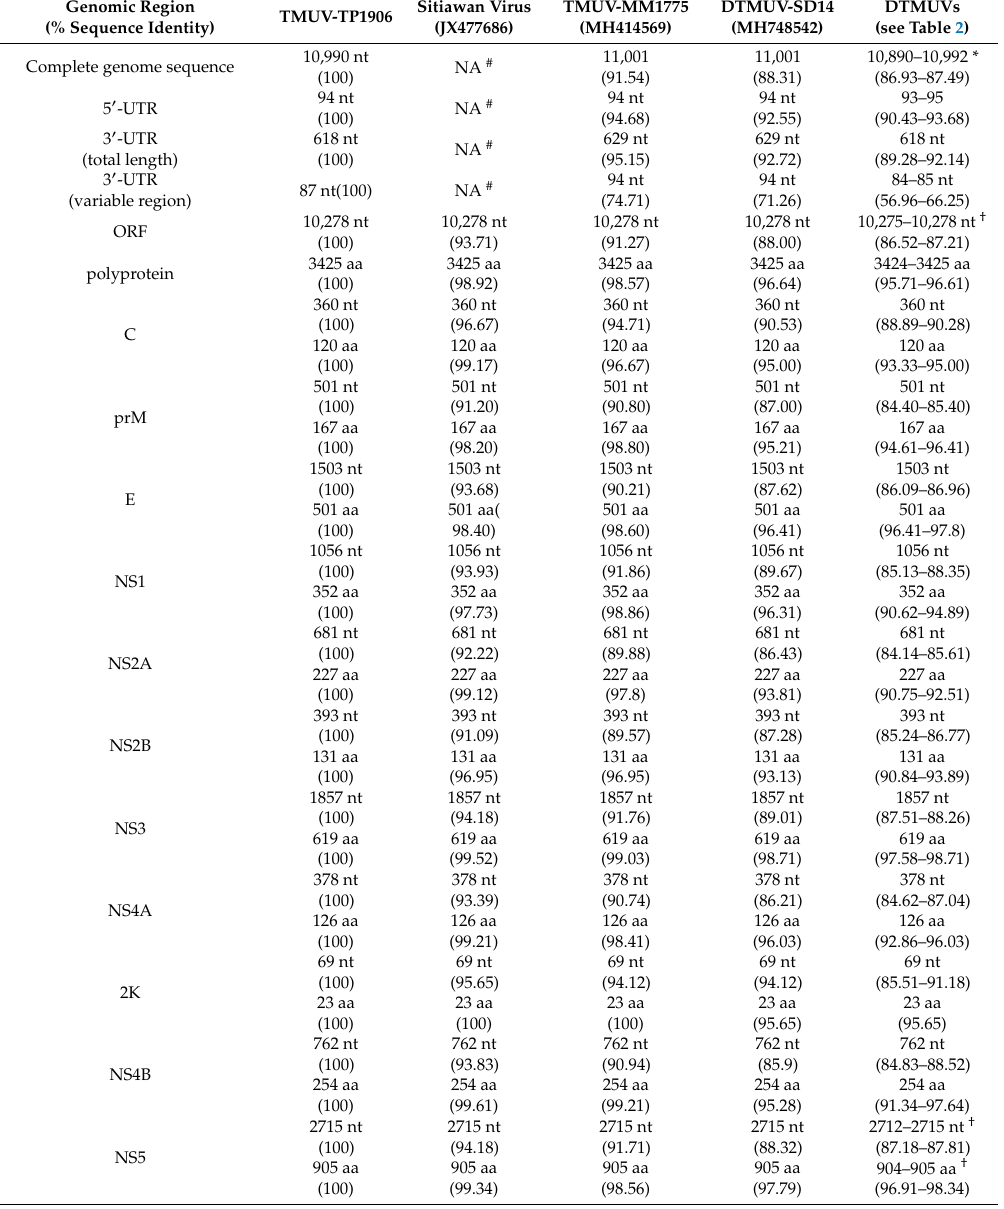
Table 4. Comparison of genomic sequences between TMUV-TP1906, Sitiawan virus and other Tembusu virus